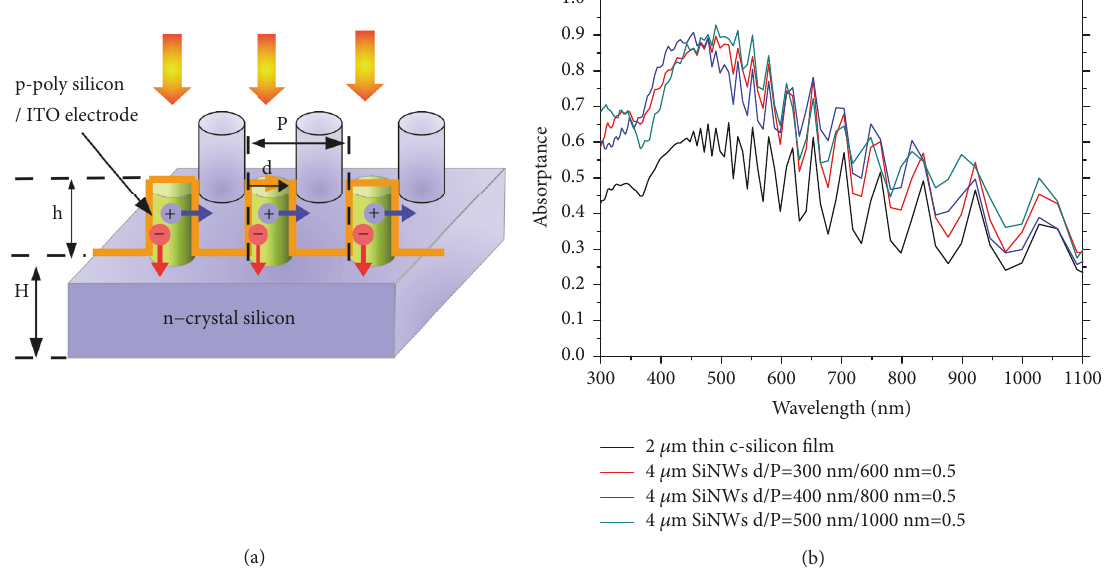
Figure 1: (a) Schematic of nanowires radial core-shell junction solar cell used in the model. The incident light is in parallel to the SiNWs axis; (b) optical absorption spectra of the SiNWs array versus diameter 300 nm, 400 nm, and 500 nm. 2 𝜇 m thick silicon substrate serves as reference. The radio of d/P is set as